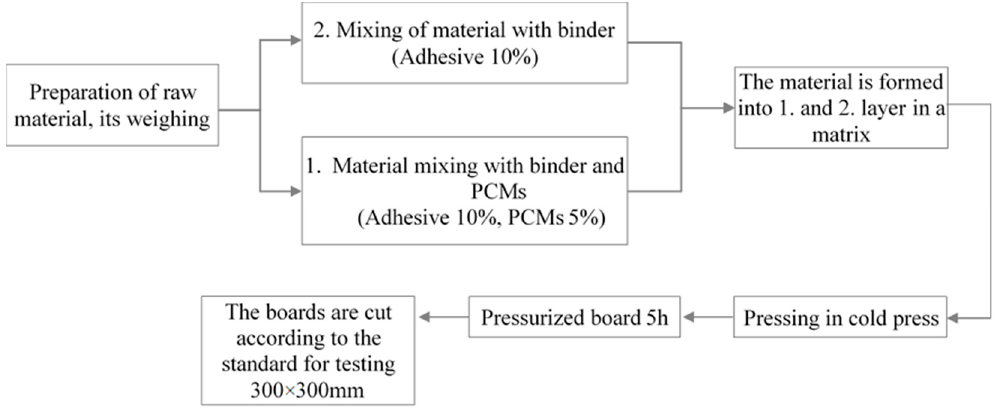
Figure 2. Preparation of the sample. Schematic drawing.